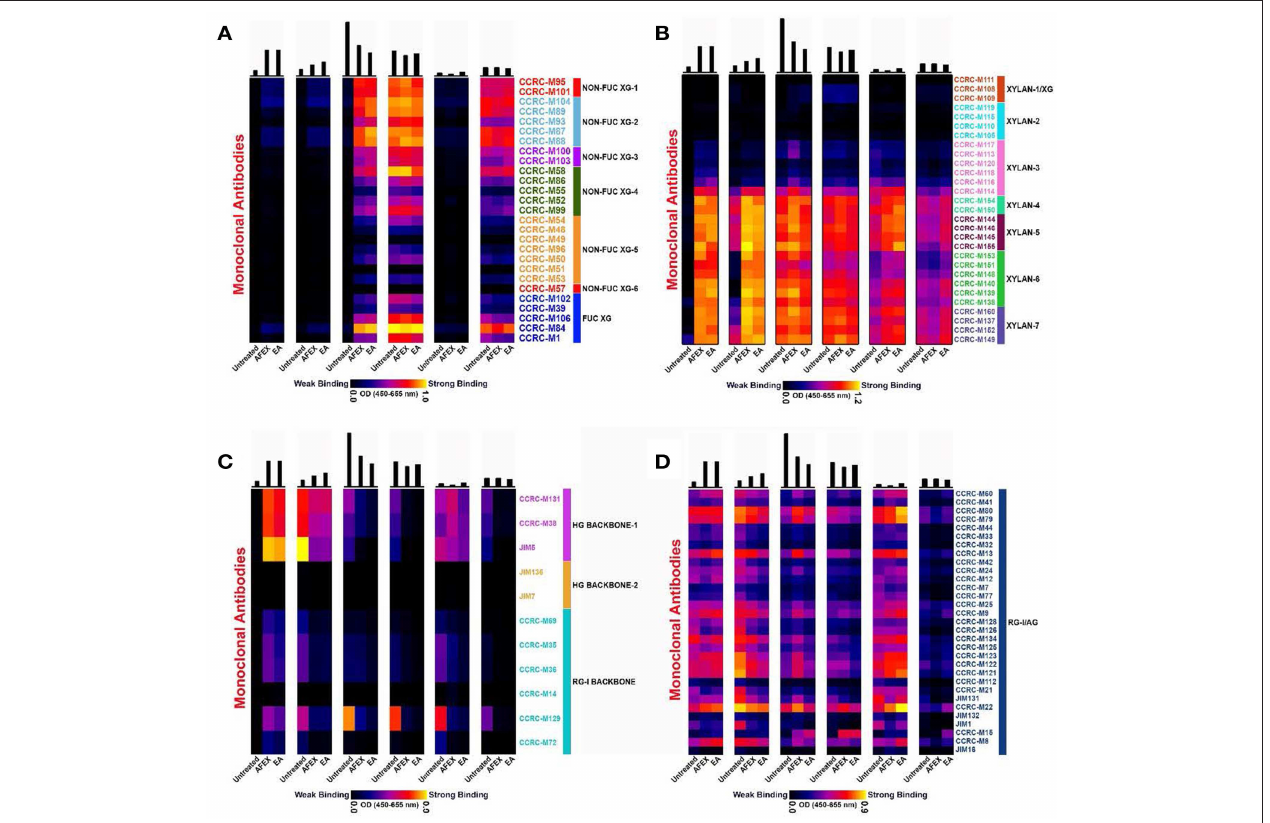
FIGURE 6 | Glycome profiling of untreated and EA/AFEX pretreated of corn stover stems. Here, (A) xylanglucans epitopes of glycome profiling heatmap; (B) unsubstituted and substituted xylan epitopes of glycome profiling heatmap; (C) pectin backbone epitopes of glycome profiling heatmap; (D) pectic-arabinogalactan epitopes of glycome profiling heatmap. The six panels from left to right are cell wall extracts namely, P1 (50mM Oxalate), P2 (50mM carbonate), P3 (1M KOH), P4 (4M KOH), P5 (100mM Chlorite), and P6 (4M KOH post